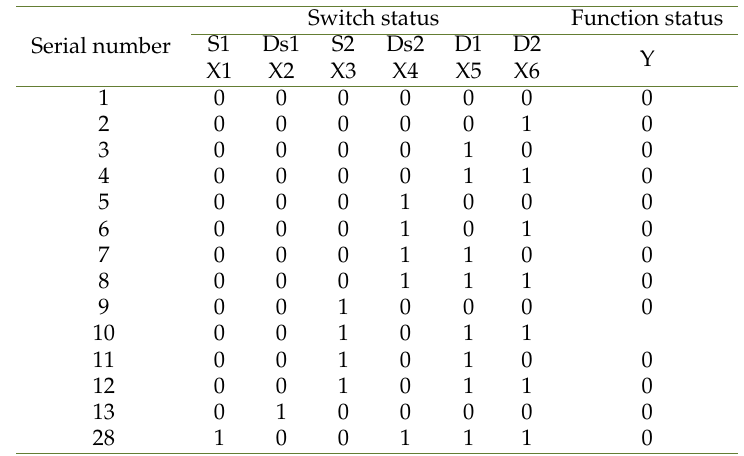
Table 4. Training sample total